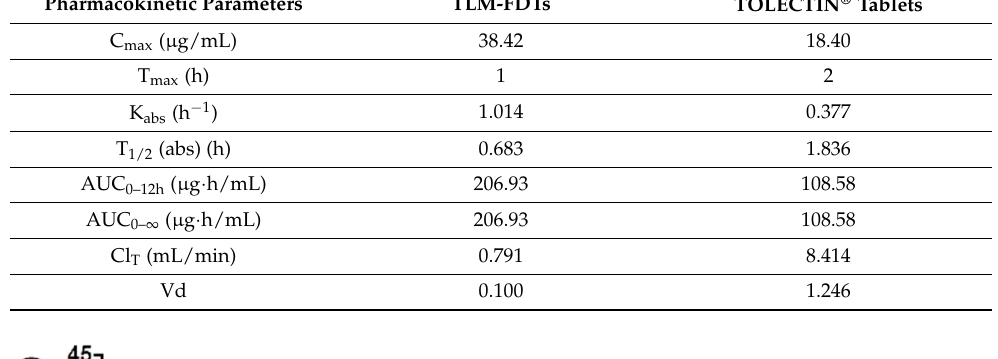
Figure 10. HPLC chromatograms of ( A ) TLM, ( B ) TLM in blank plasma, ( C ) plasma samples taken after injection of TLM ‐ FDTs, and ( D ) blank plasma.